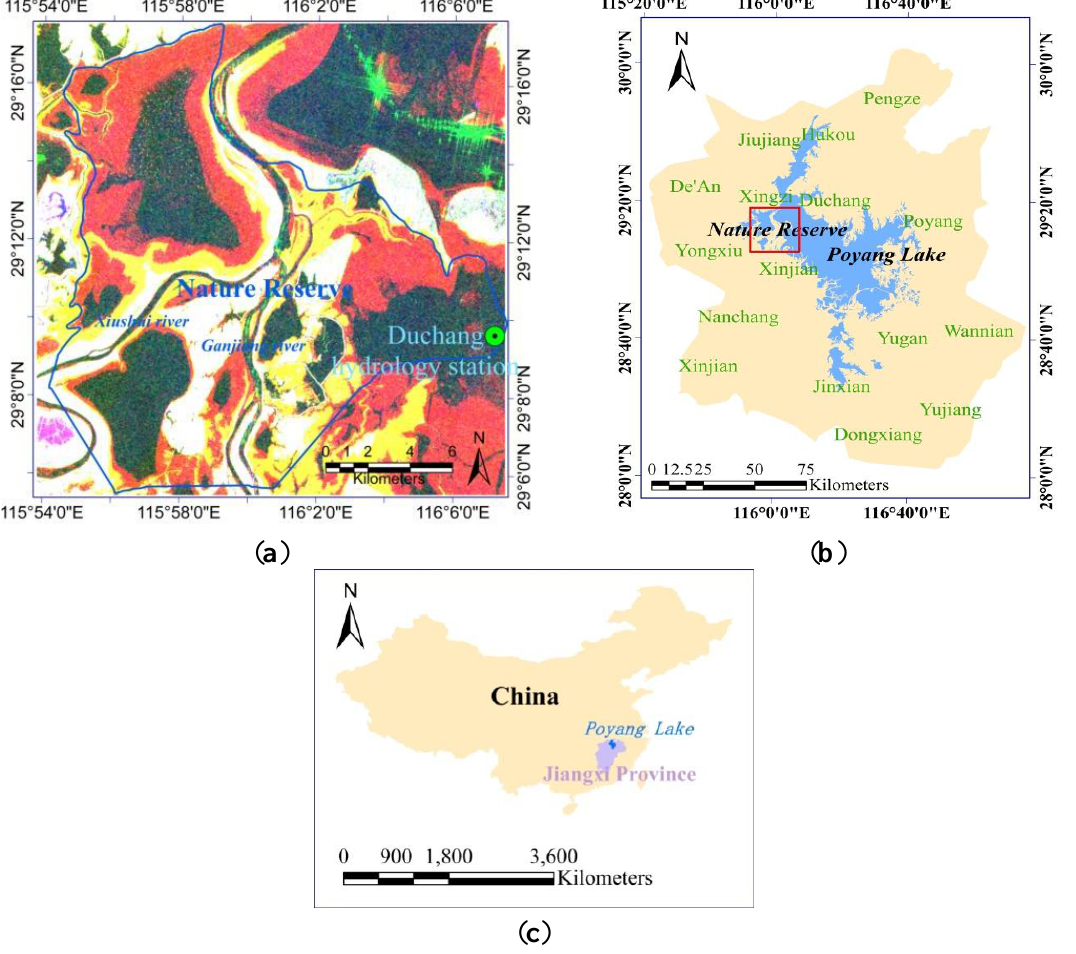
Figure 1. ( a ) is a phase color synthesis image of the subset HH-polarized data acquired on 25 April (red), 25 May (green), and 18 September (blue) of 2005; the red areas colonized by Carex spp . are exposed substrate during low water stage, the yellow areas colonized by Carex spp . and emergent macrophytes such as Phragmites communis are partly flooded during high water stage, and the white areas colonized by emergent macrophytes and trees are exposed during peak flood stage; ( b ) is the geo-location of Poyang Lake Nature Reserve and the acquired images in Poyang Lake region; and ( c ) is the geo-location of Jiangxi Province and Poyang Lake in